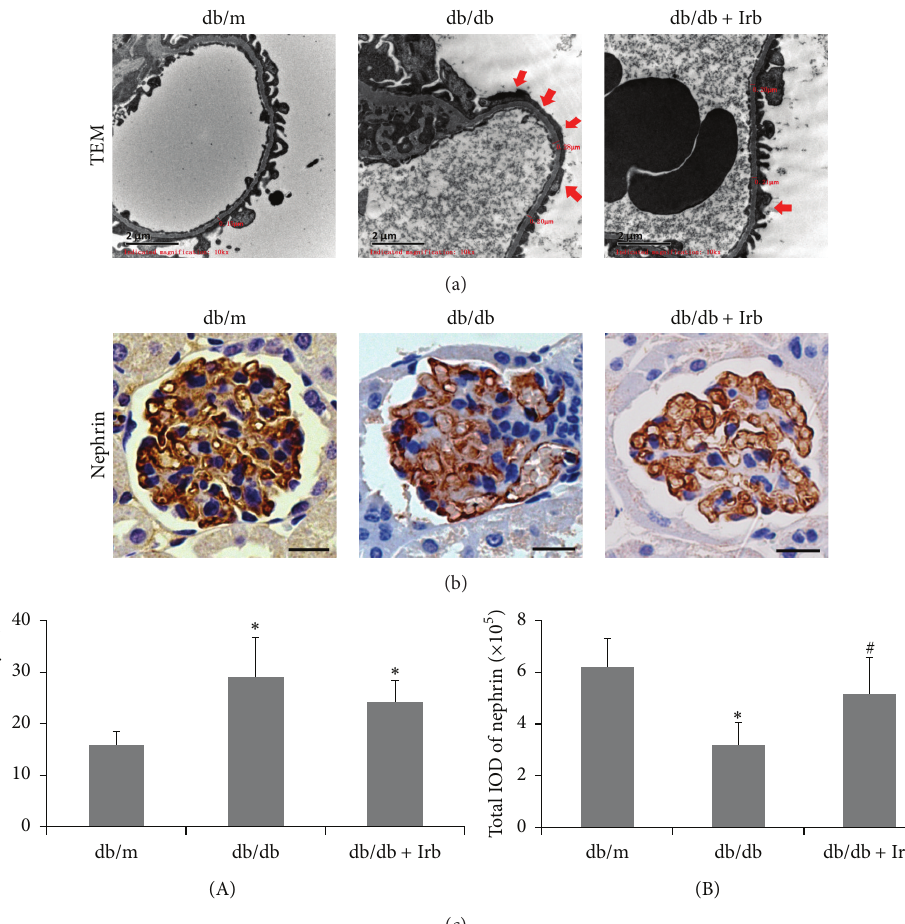
Figure 3: Irb alleviated diabetes-induced podocyte injury and the thickening of the GBM. (a) Representative fields of podocyte foot processes under TEM (scale bars: 2 𝜇 m, red arrow indicates podocyte foot process effacement). (b) Representative fields of nephrin, as labeled by immunohistochemical staining (scale bars: 50 𝜇 m). (c) Quantification of the GBM thickness (A) and immunohistochemical staining (B). The bars in panel (c) show the mean expression in arbitrary units (error bars, S.D.). ∗ 𝑃 < 0.05 compared with db/m; # 𝑃 < 0.05 compared with db/db, 𝑡 -test.